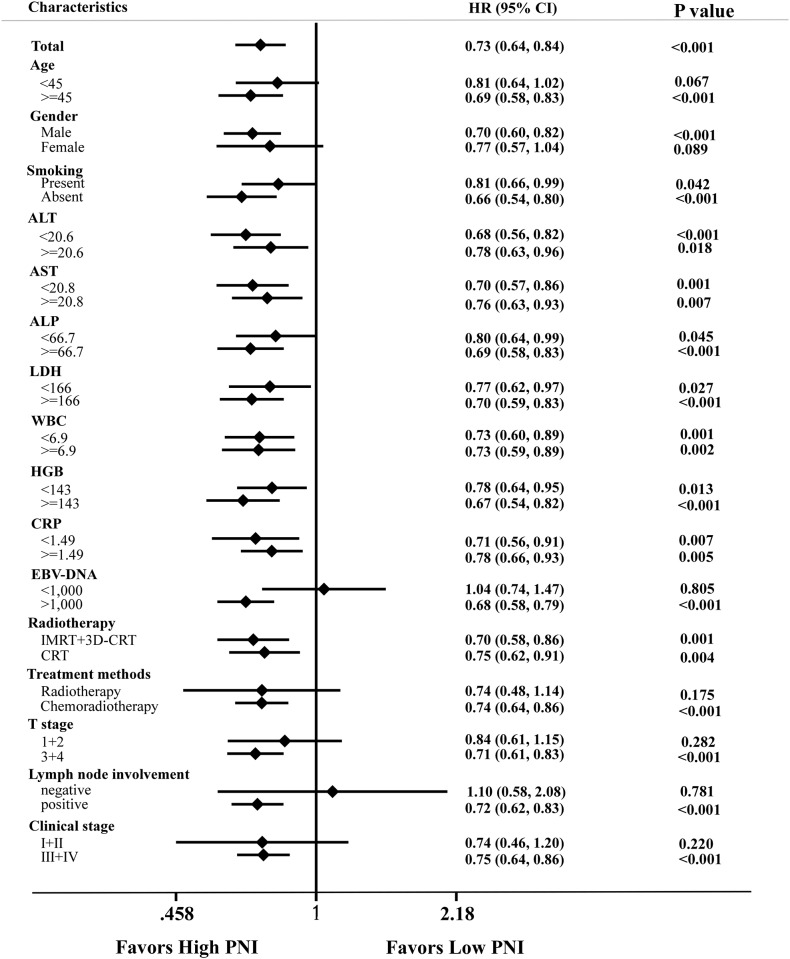
Forest plot of subgroup effects for distant metastasis-free survival (DMFS) in 1,168 patients with nasopharyngeal carcinoma who underwent definitive radiotherapy.Subgroups are defined by factors showing significant associations between the PNI and DMFS. Univariate hazard ratios and 95% CI (bars) are presented. WBC, white blood cell count; HGB, hemoglobin; ALT, alanine transaminase; AST, aspartate transaminase; ALP, alkaline phosphatase; LDH, lactate dehydrogenase; CRP, C-reactive protein; ALB, albumin; EBV, Epstein-Barr virus DNA; CRT, conventional radiotherapy: IMRT, intensity-modulated radiation therapy; 3D-CRT, three-dimensional conformal radiation therapy; RT, radiotherapy; chemo-radiotherapy, chemotherapy plus radiotherapy.